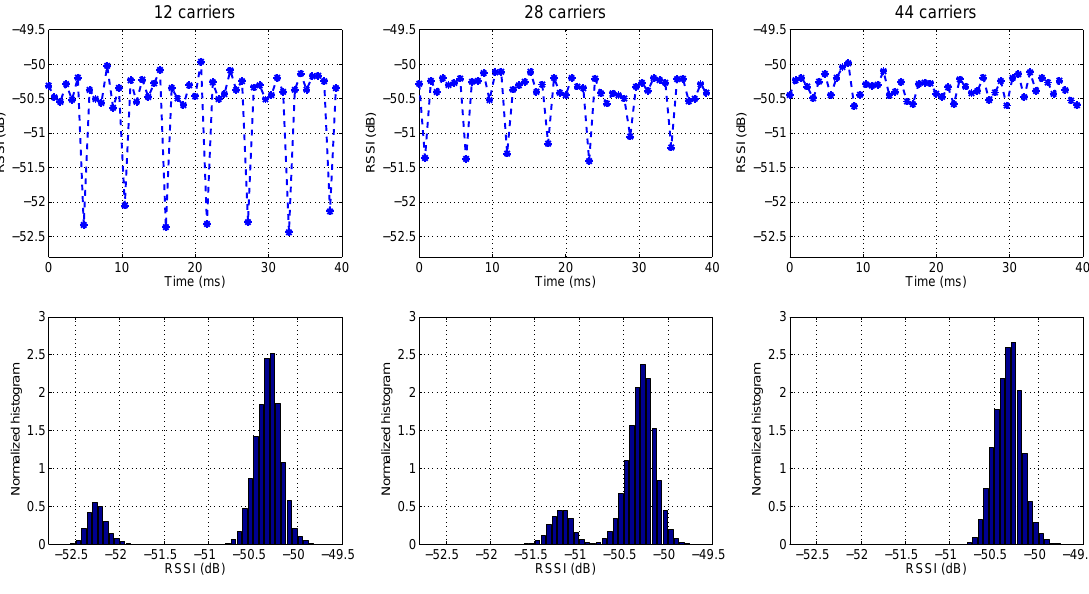
Figure 4. The RSSI of OFDM signals generated by GNU Radio, with a variable amount of subcarriers in the last symbol of a packet (indicated in the title of the graphs); the first row displays RSSI measurements over time, while the corresponding histograms are displayed in the second row.